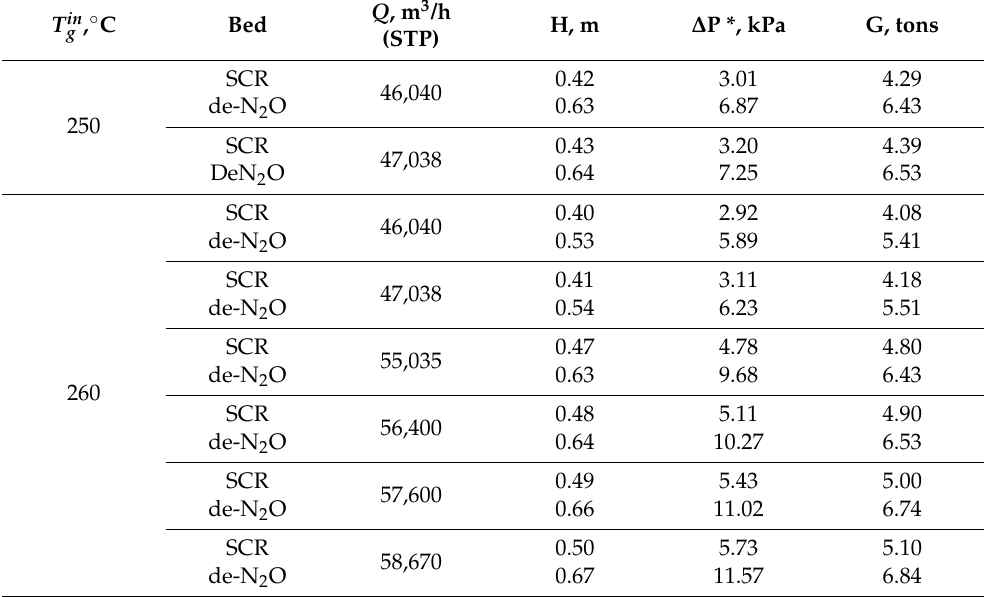
Table 3. The bed heights, the total pressure drop along the beds, and catalyst loading. T in g , ◦